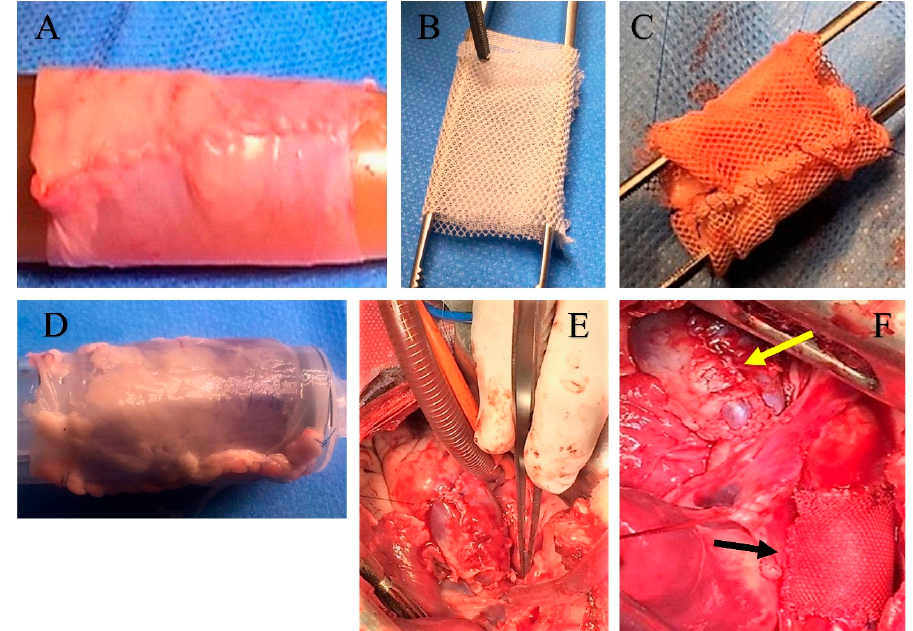
Figure 1. Pulmonary autograft before and after implantation. ( A ) Pulmonary autograft before implantation; ( B ) External expanded polytetrafluoroethylene (e-PTFE) reinforcement. ( C ) Pulmonary autograft reinforced with external e-PTFE. ( D ) Pericardial patch used for reconstruction of right ventricular outflow tract (RVOT); ( E ) Neopulmonary trunk implanted; ( F ) Pulmonary autograft reinforced with e-PTFE (black arrow) and neopulmonary trunk (yellow arrow) implanted.